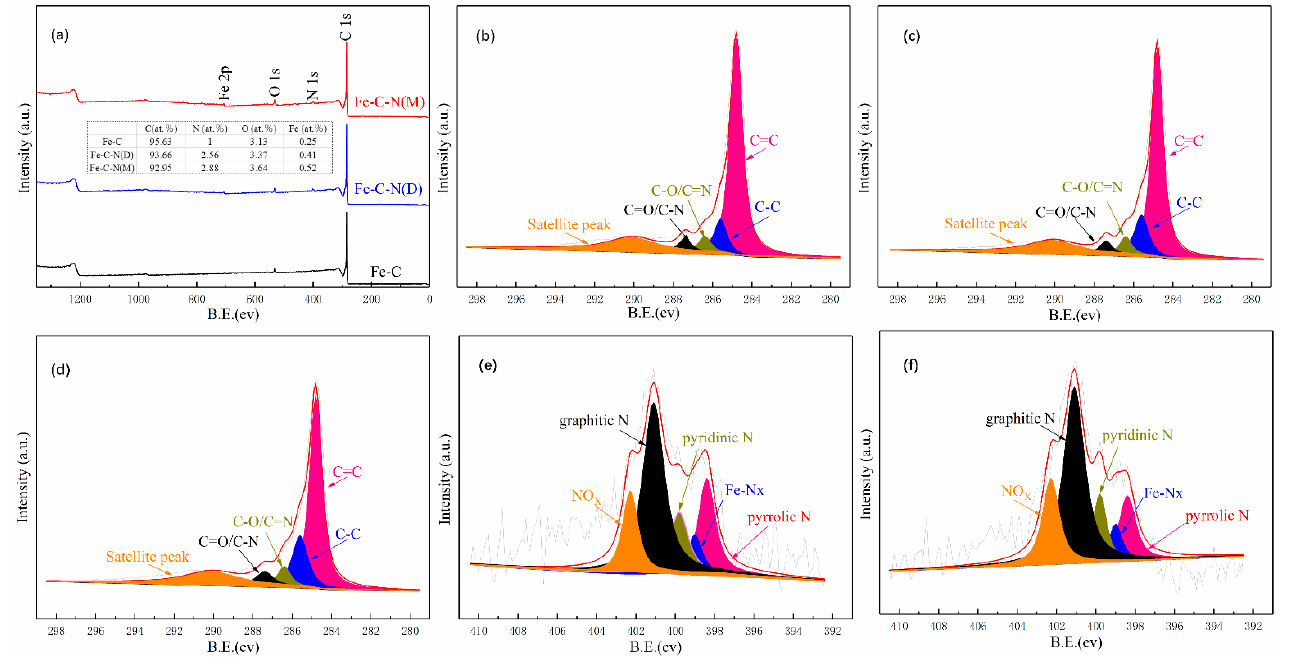
Figure 5. ( a )-Total XPS spectrum; ( b – d )-C1s spectra of Fe-C, Fe-C-N(D) and Fe-C-N(M); ( e , f )-N1s spectra of Fe-C-N(D) and Fe-C-N(M).